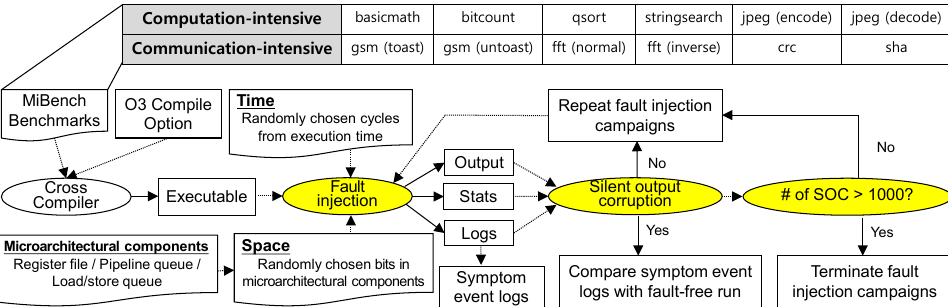
Figure 5. Diagram of our fault injection framework. In our campaigns, we gather symptom event logs from more than 1000 silent output corruptions (SOCs) per benchmark through more than 600,000 fault